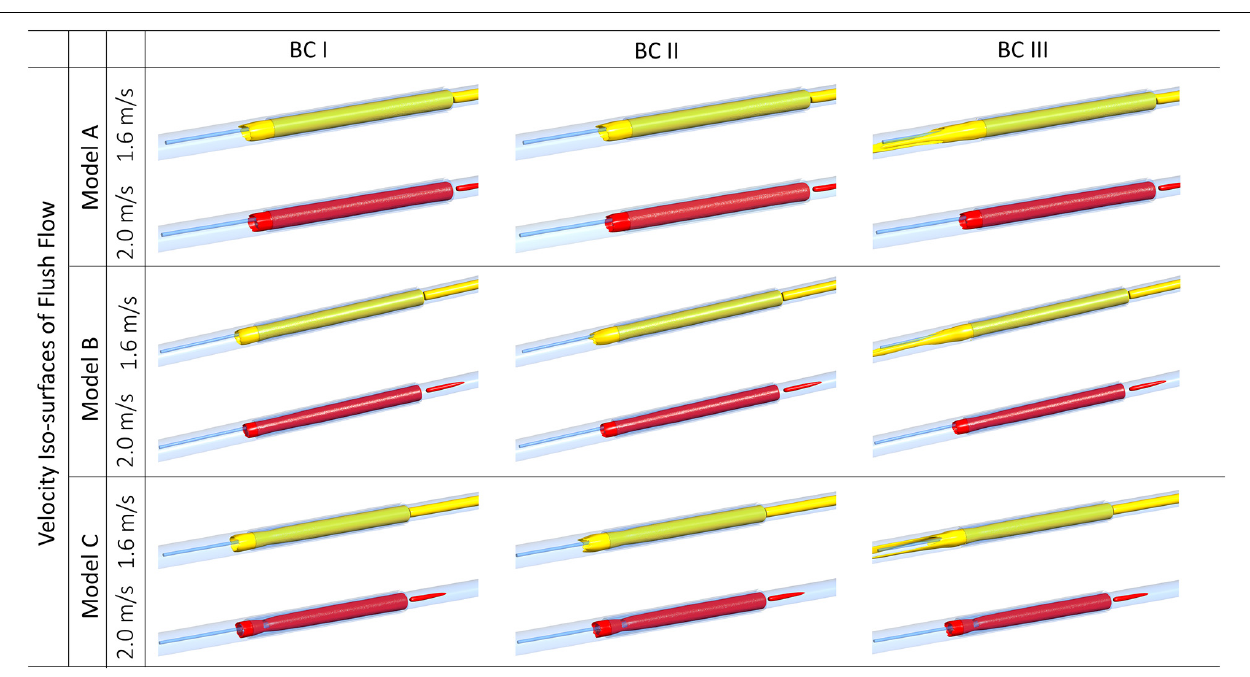
Frontiers in Physiology |